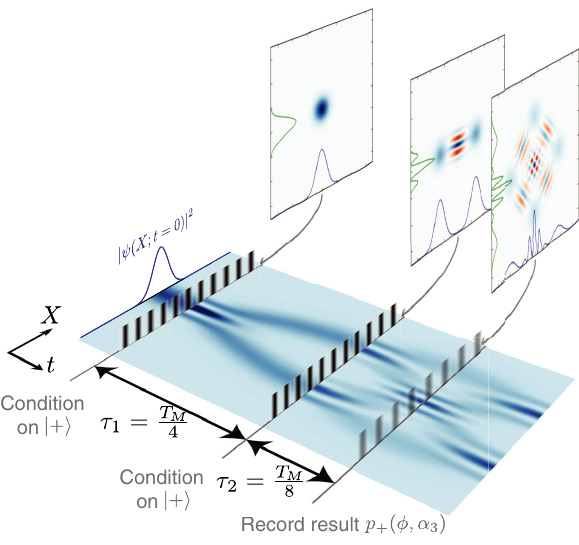
FIG. 4. Protocol for detecting nanomechanical interference. Following cooling (not shown), the first grating operation, with amplitude α 1 , diffracts the resonator wave function into a superposition of left-moving and right-moving components. After an interval τ 1 of free evolution, here set as a quarter of the mechanical period T , a second grating operation is applied M with amplitude α 2 . This leads to recombination of the two components an eighth of a mechanical period later. To measure the resulting interference, a third (unconditioned) Ramsey se- = 8 ). The resulting quence is applied after time τ 2 (here set to T M qubit return probability p ð α 3 ; ϕ Þ probes the mechanical inter- þ ference fringes. The main panel shows a simulated resonator spatial density j ψ ð X Þj 2 , beginning from the ground state, plotted as a function of displacement and time, with the grating operations and the final Ramsey measurement operation indi- cated schematically as filters. The resonator Wigner distributions and marginals (see Fig. 5) are shown as insets just before each filter. To illustrate the continuing periodic evolution of the resonator wave function, the spatial density beyond the final Ramsey measurement is plotted as it would be probed by applying the measurement instead at a later